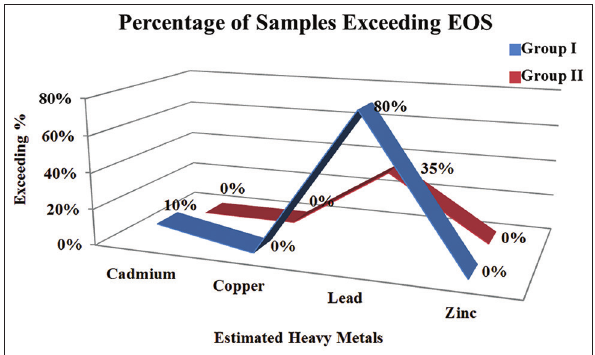
Figure-1: Frequency distribution of concentration levels of cadmium, copper, lead, and zinc in the quail meat with compared to Egyptian